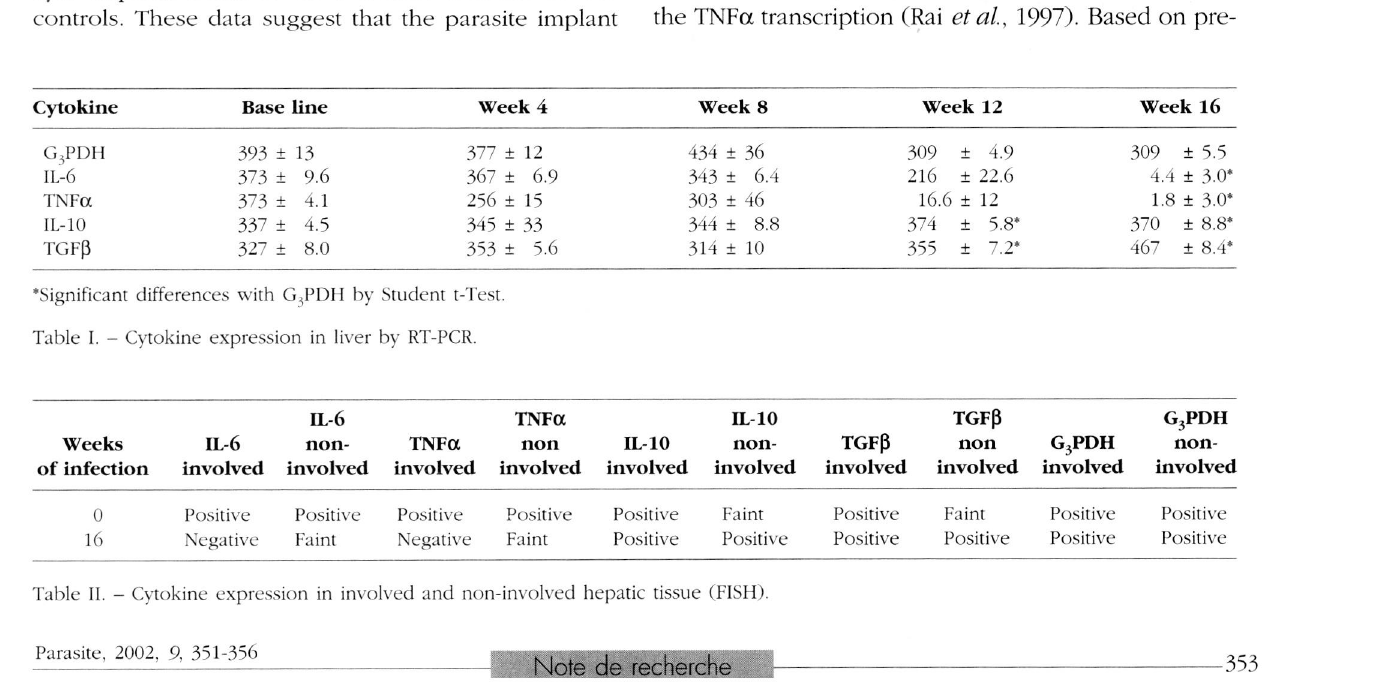
Table II. - Cytokine expression in involved and non-involved hepatic tissue